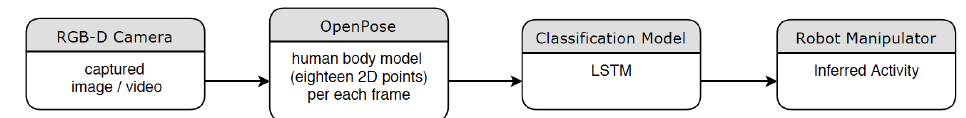
Figure 15. The workflow proposed in the paper to obtain, from the acquired sequence of images/video and using the learned LSTM model, the inferred activity to be sent to the robot manipulator.